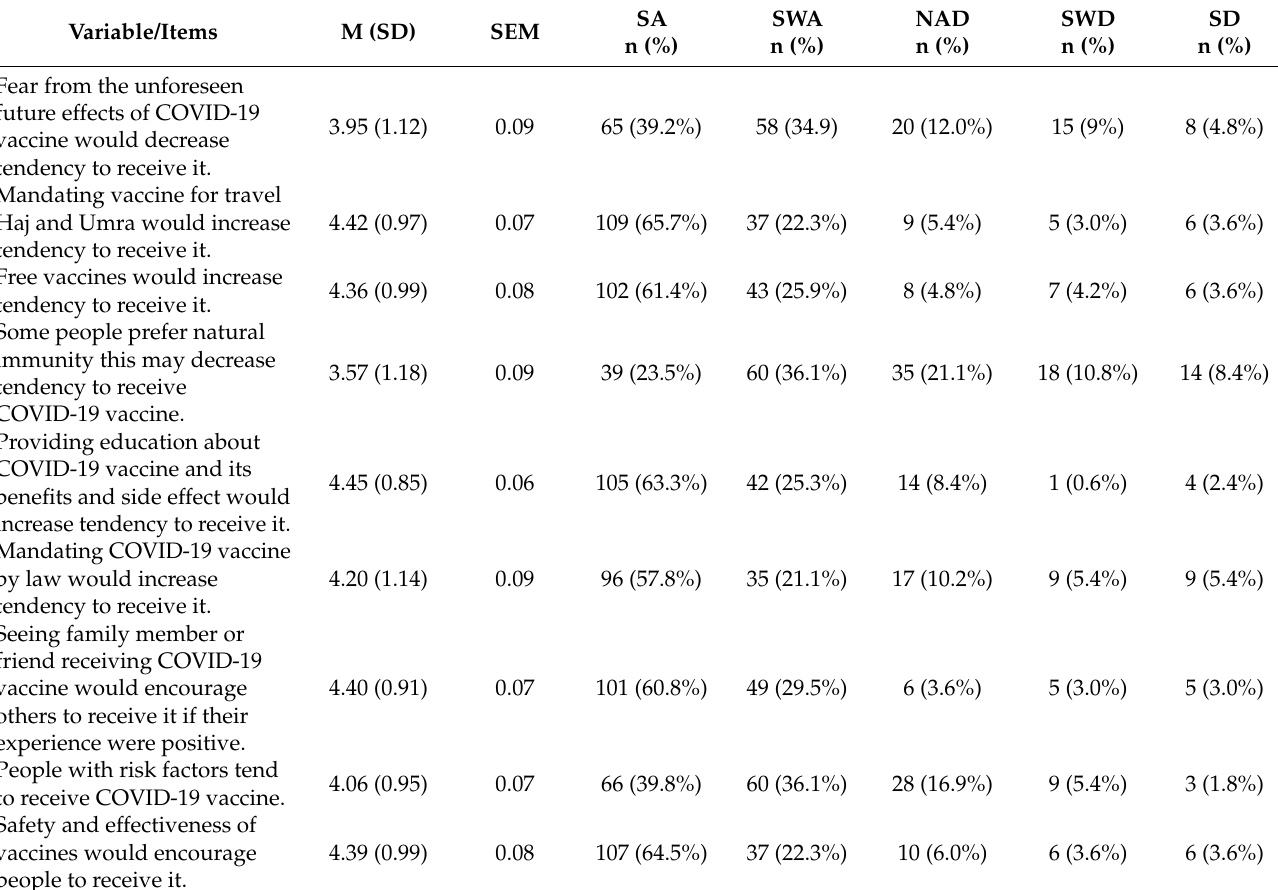
Table 3. Summary Statistics of the Factors influencing receiving COVID-19 vaccination (n = 173).